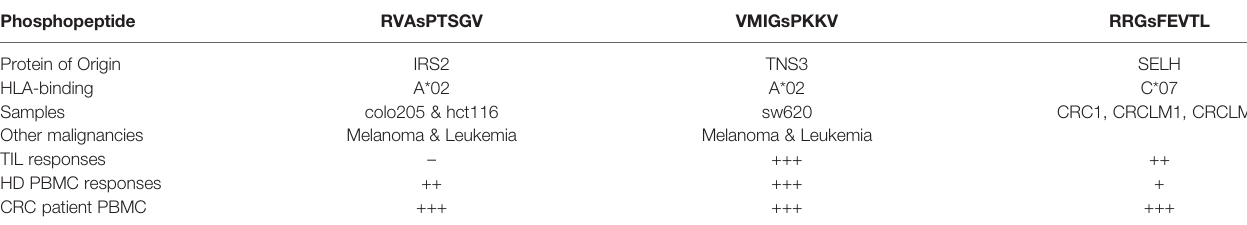
TABLE 1 | Summary of responses to key CRC HLA-I phosphopeptides.